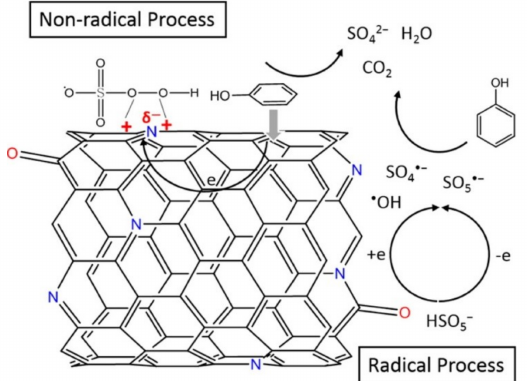
Figure 7. Mechanism of peroxymonosulfate (PMS) activation on N-Doped CNTs. Reprinted with permission from [83]. Copyright (2015) American Chemical